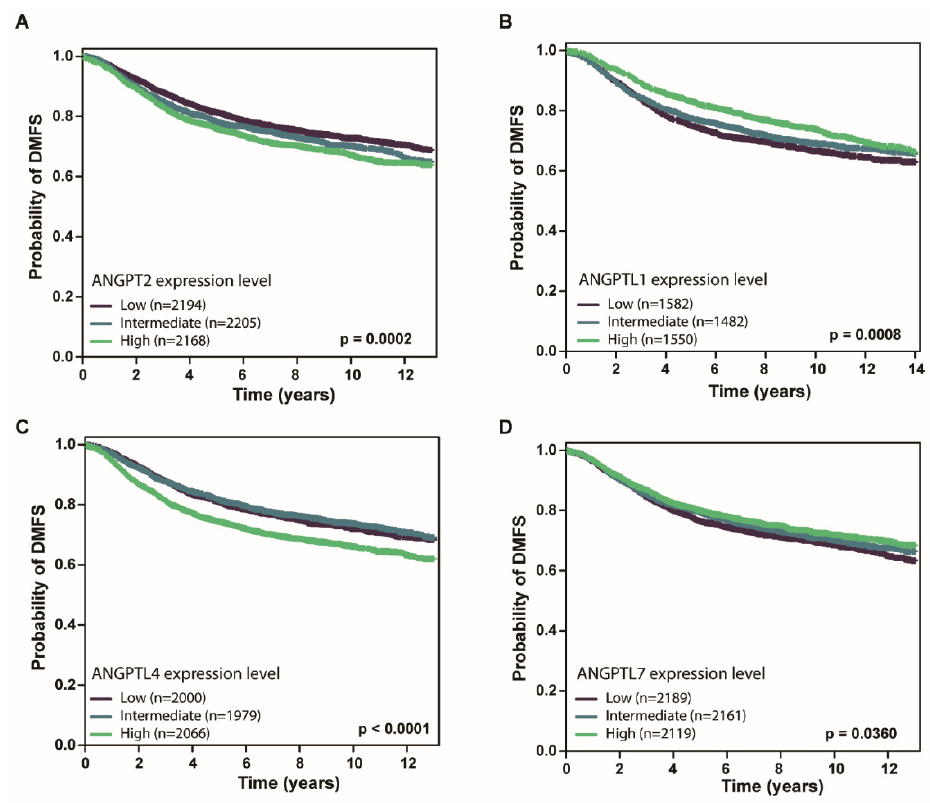
Figure 4. Association between ANGPT / ANGPTL genes and DMFS in breast cancers. Transcriptional levels of ANGPT2 ( A ), ANGPTL1 ( B ), ANGPTL4 ( C ), and ANGPTL7 ( D ) are significantly associated with distant metastasis-free survival (DMFS) in BC patients.